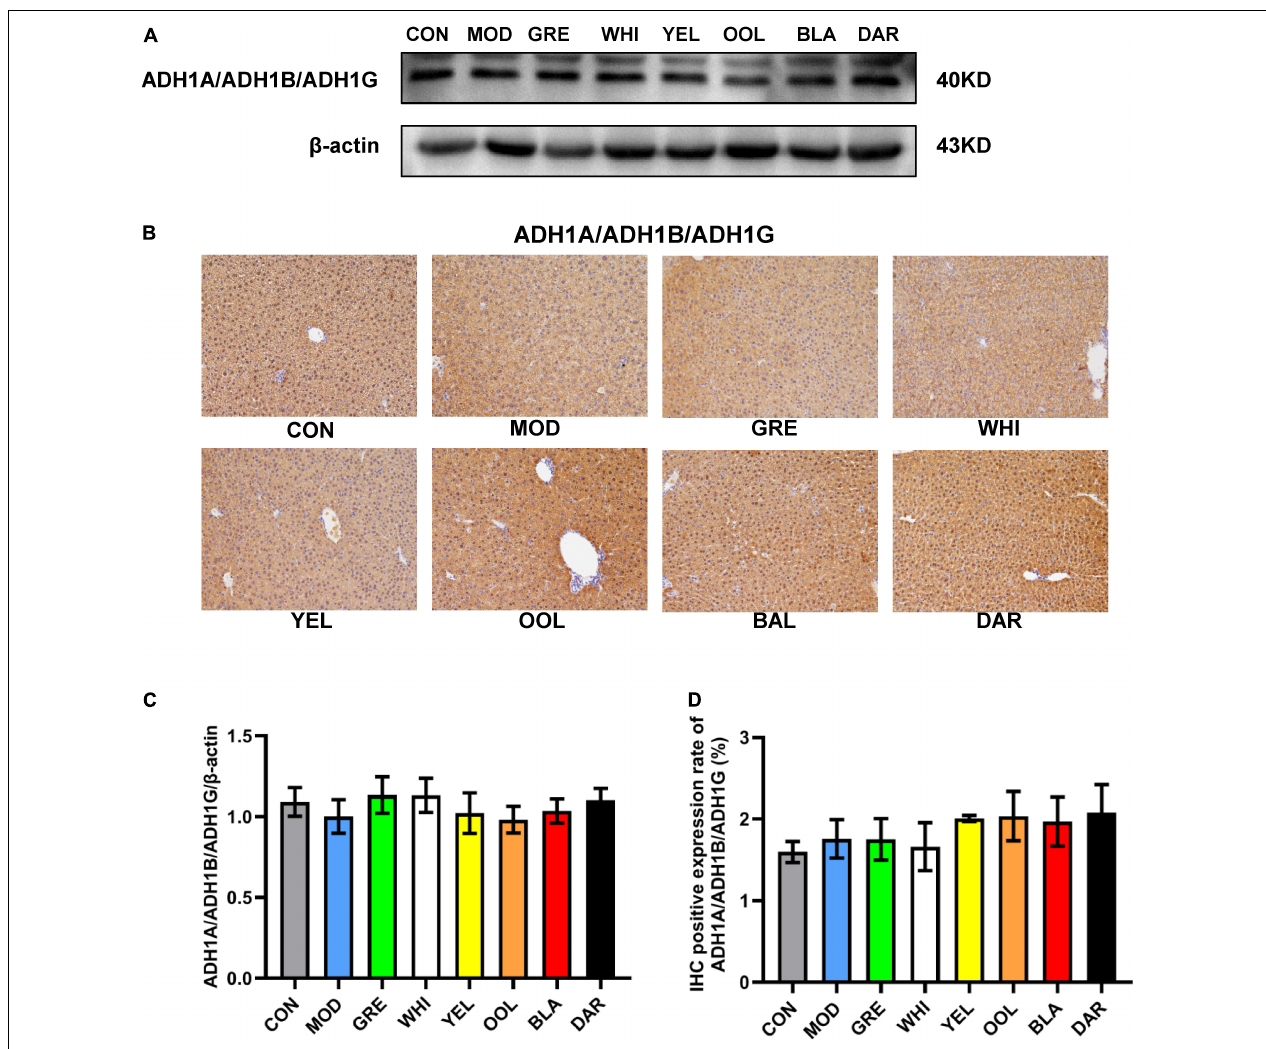
FIGURE 10 | Effects of WEATs on ADH1A/ADH1B/ADH1G expression in the liver of mice. Representative immunoblots (A) and IHC images (B) of ADH1A/ADH1B/ADH1G expression in the liver. Quantification of ADH1A/ADH1B/ADH1G expression by western blotting (C) and IHC (D) . Each value represents the mean ± SEM ( n =